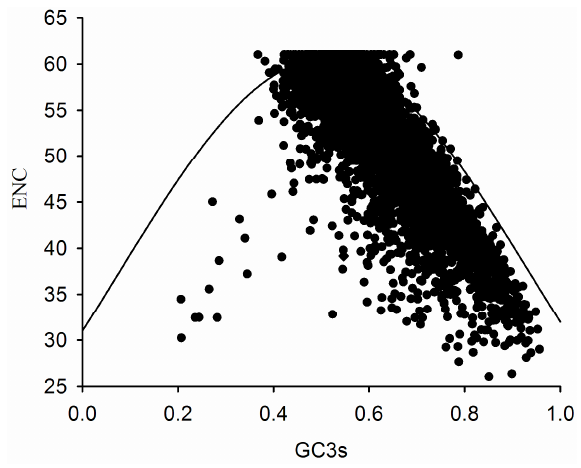
Figure 3. Effective number of codons ENC-plot showing relationship between ENC and GC3s.